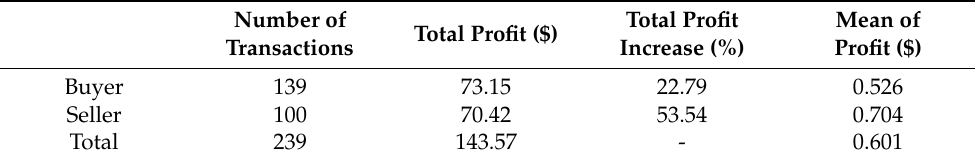
Table 5. Result of the day-ahead trading process (including double auction and smart